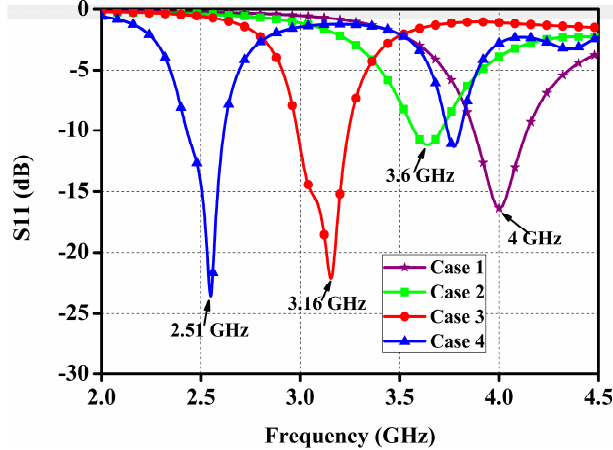
Figure 6. Simulated S11 of four cases embedded in the same phantom.